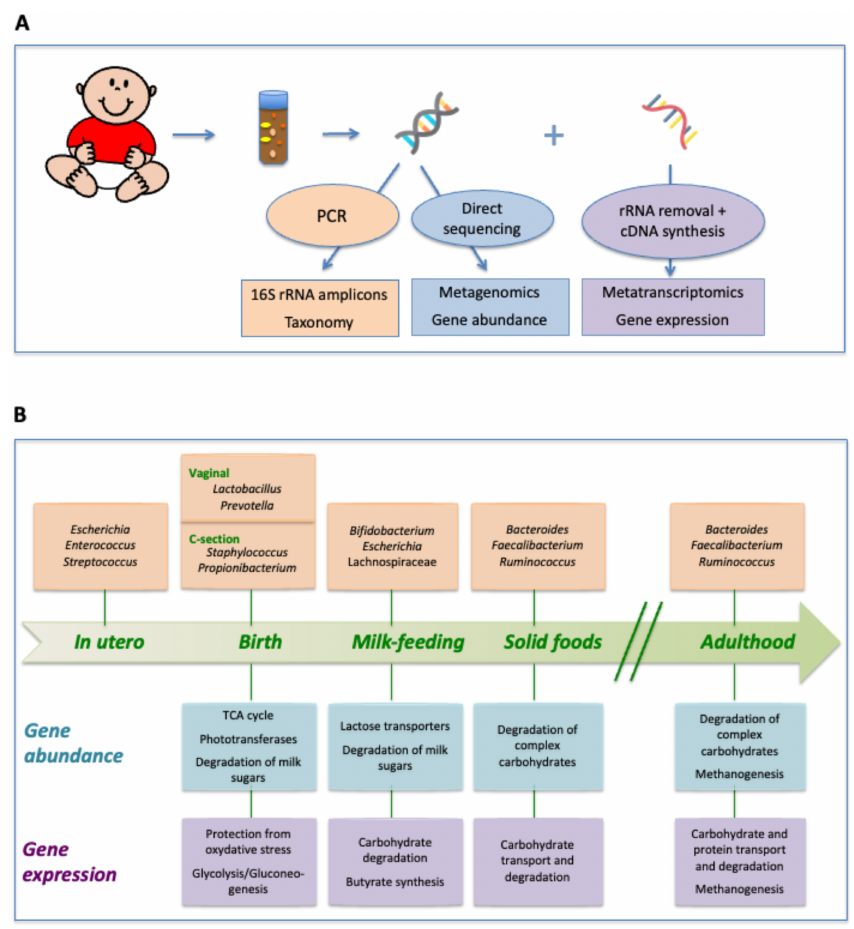
Figure 1. ( A ) DNA- and RNA-based omic approaches employed for the characterization of the infant gut microbiome. ( B ) Changes in taxonomic composition, gene abundance, and gene expression patterns during infant